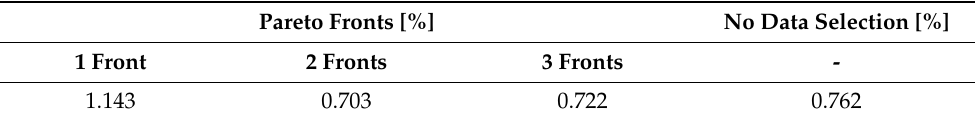
Table 6. MAPE values for Pareto fronts and ‘no data selection’ models for the third verification case. Pareto Fronts [%] No Data Selection